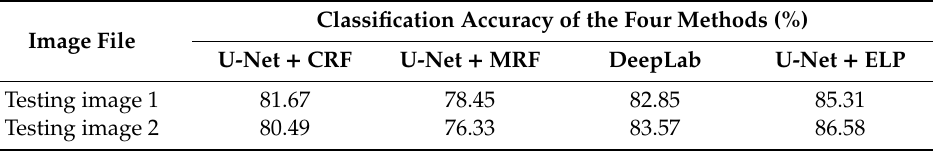
Table 6. Classification accuracies of the four